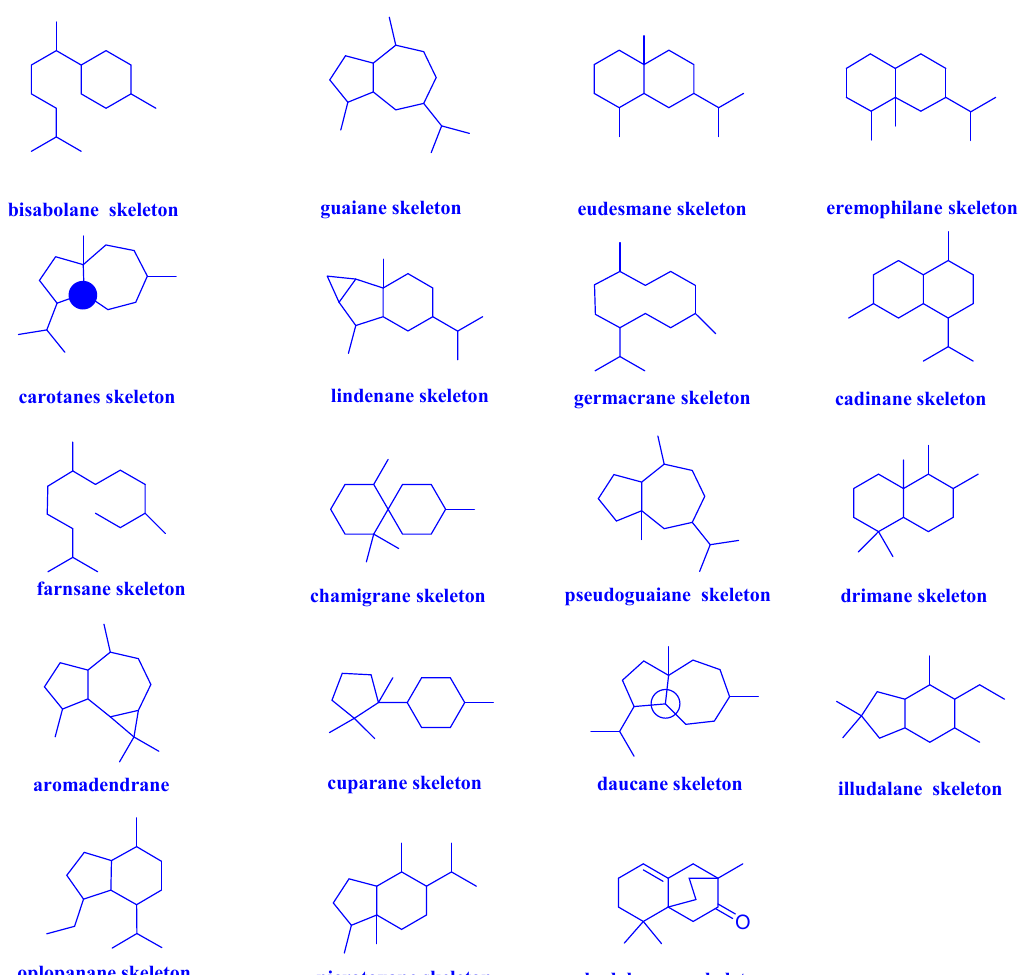
Figure 1. Different types of sesquiterpenoid skeletons.